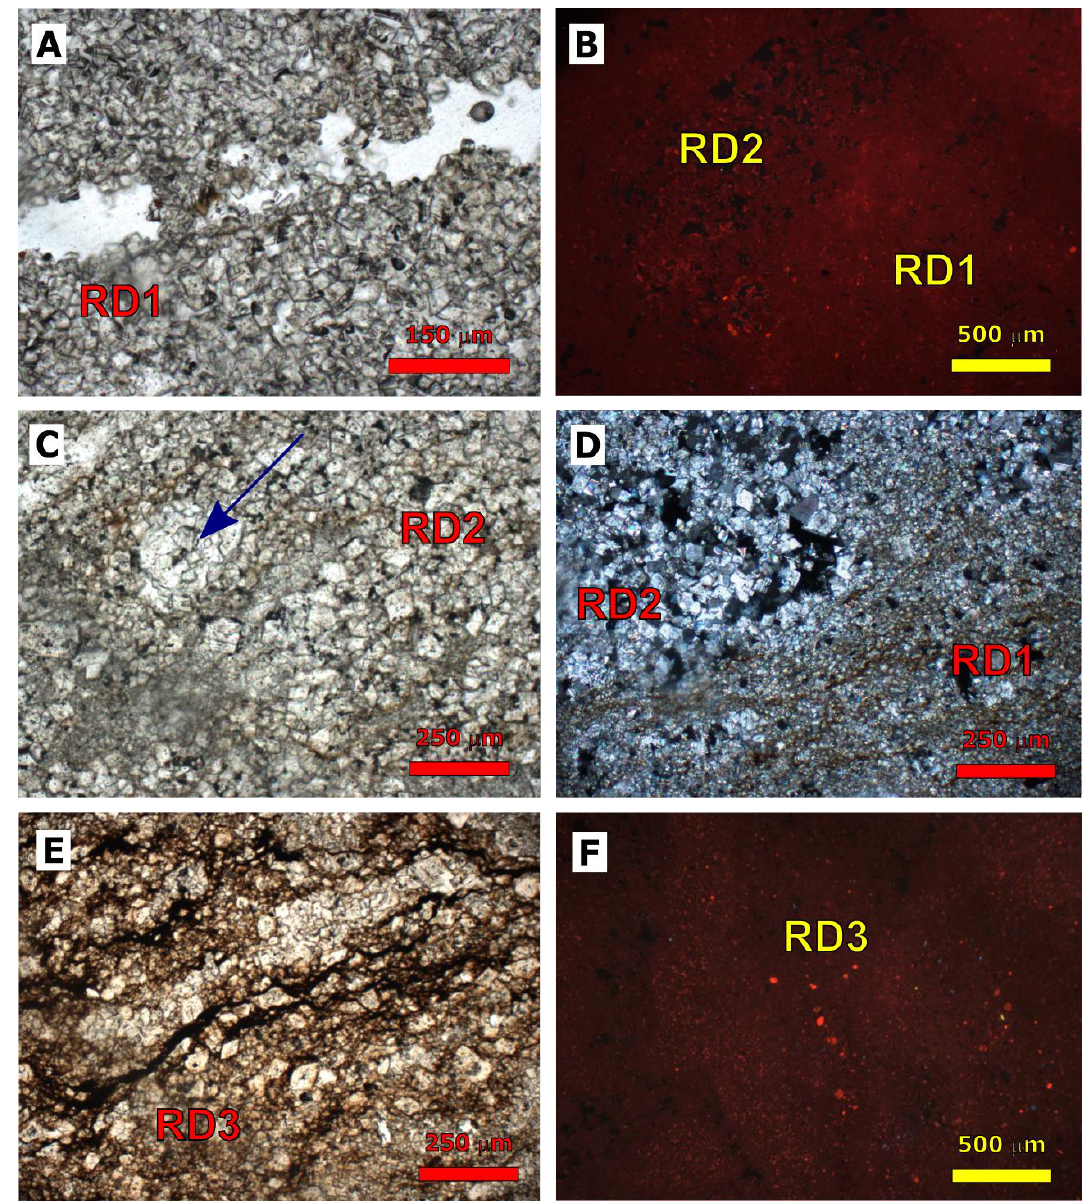
Figure 7. Dolomitization in Devonian formations. ( A ) Photomicrograph (PPL) of planar-e to planar-s, pervasive replacive micro to fine crystalline dolomite matrix (RD1). Sample 1-1; well: DGR1-CR1; depth: 23.5 m; ( B ) CL photomicrograph of pervasive replacive, fine-crystalline dolomite matrix (RD1) and pervasive replacive, medium crystalline dolomite matrix (RD2) showing red luminescence. Sample 8-4; well: DGR8-CR22; depth: 59.06 m; ( C ) photomicrograph (XPL) of planar-e to planar-s, medium crystalline dolomite matrix (RD2) pervasively replacing precursor limestone and partially replacing allochems fragments (blue arrow). Sample 1-4; well: DGR1-CR2 (3); depth: 27.75 m; ( D ) photomicrograph (XPL) of planar-e to planar-s, pervasive replacive medium crystalline dolomite matrix (RD2) with higher intercrystalline porosity (black areas) compared to the pervasive replacive micro to fine-crystalline dolomite matrix (RD1). Sample 1-3-2; well: DGR1-CR2 (2); depth: 26.95 m; ( E ) photomicrograph (PPL) of planar-e to planar-s, selective replacive medium crystalline dolomite matrix (RD3) associated with dissolution seams showing dark cores and clear rims. Sample 8-4; well: DGR8-CR22; depth: 59.06 m. ( F ) CL photomicrograph of selective replacive medium crystalline dolomite matrix (RD3) showing dull to red luminescence. Sample 1-3-2; well: DGR1-CR2 (2); depth: 313.31